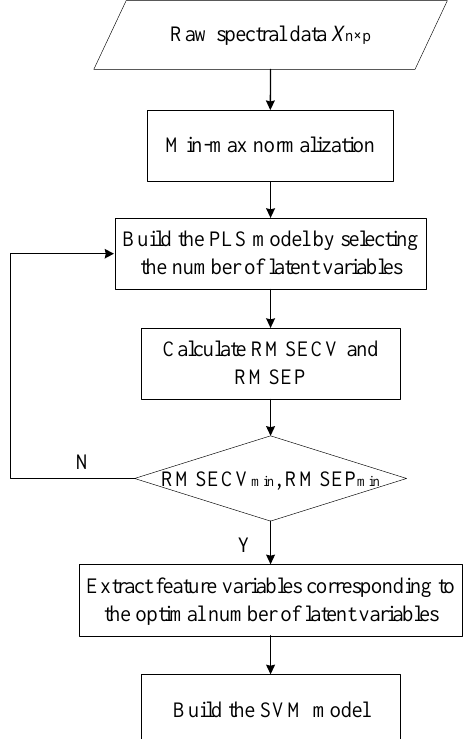
Figure 2. Flowchart of the partial least squares – support vector machine (PLS-SVM) model. RMSECV: root mean square error of cross-validation; RMSEP: root mean square error of prediction.